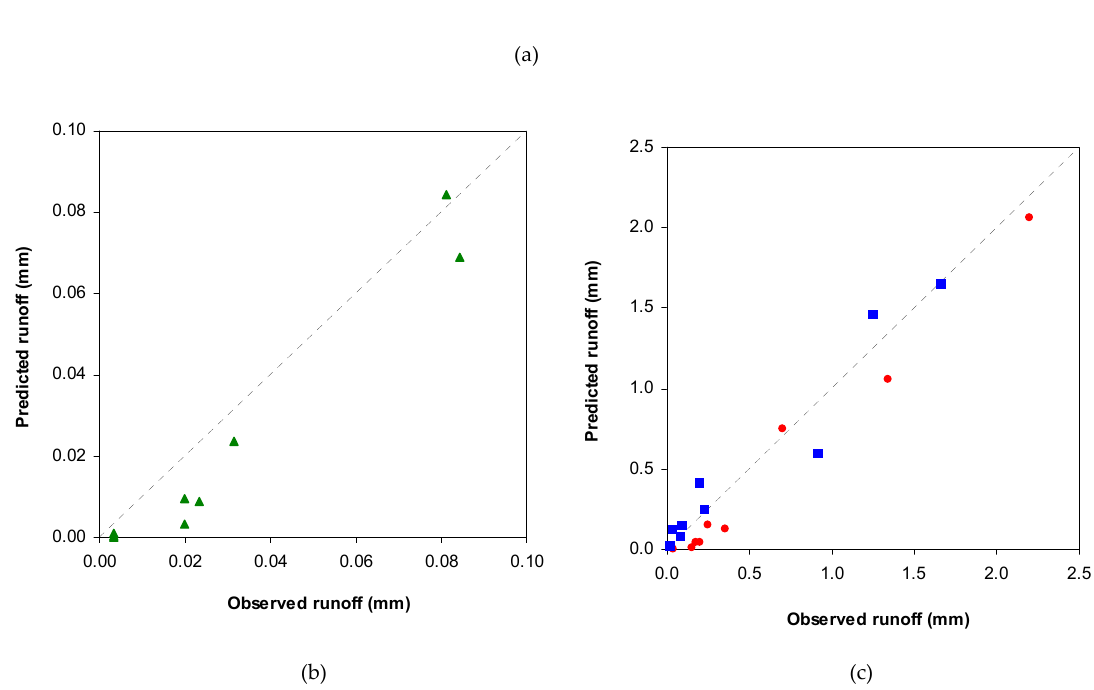
Figure 6. Scatterplots of runoff observations vs. predictions using the curve number model in plots subject to prescribed fire (Lezuza, a ), and wildfire (Li é tor, control soils, b , and burned soils, c ) (Castilla La Mancha, Spain).